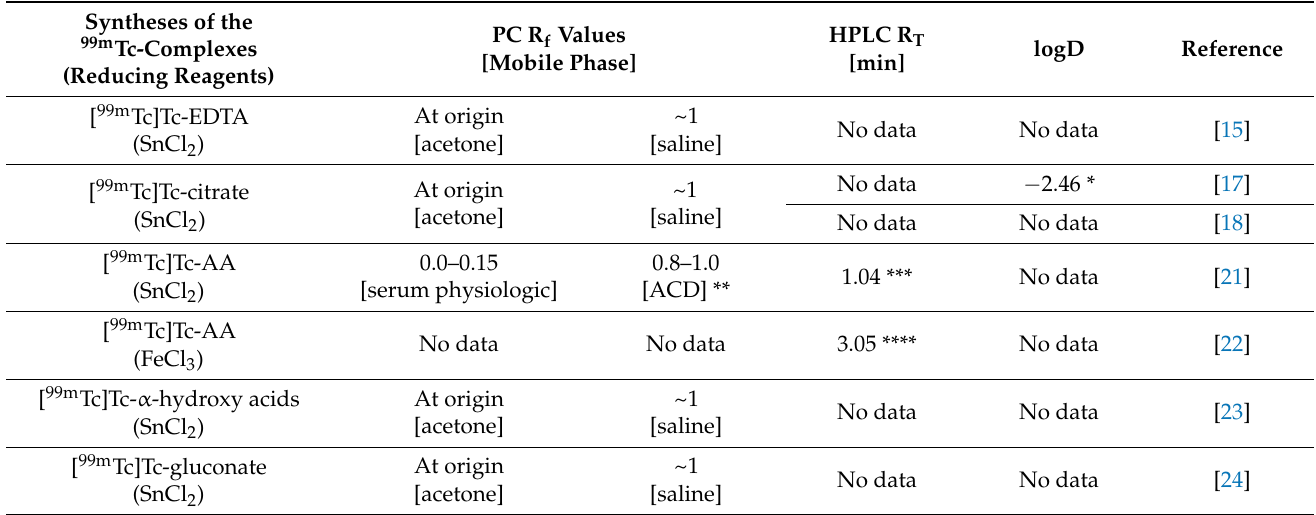
Table 2. Physicochemical parameters of the 99m